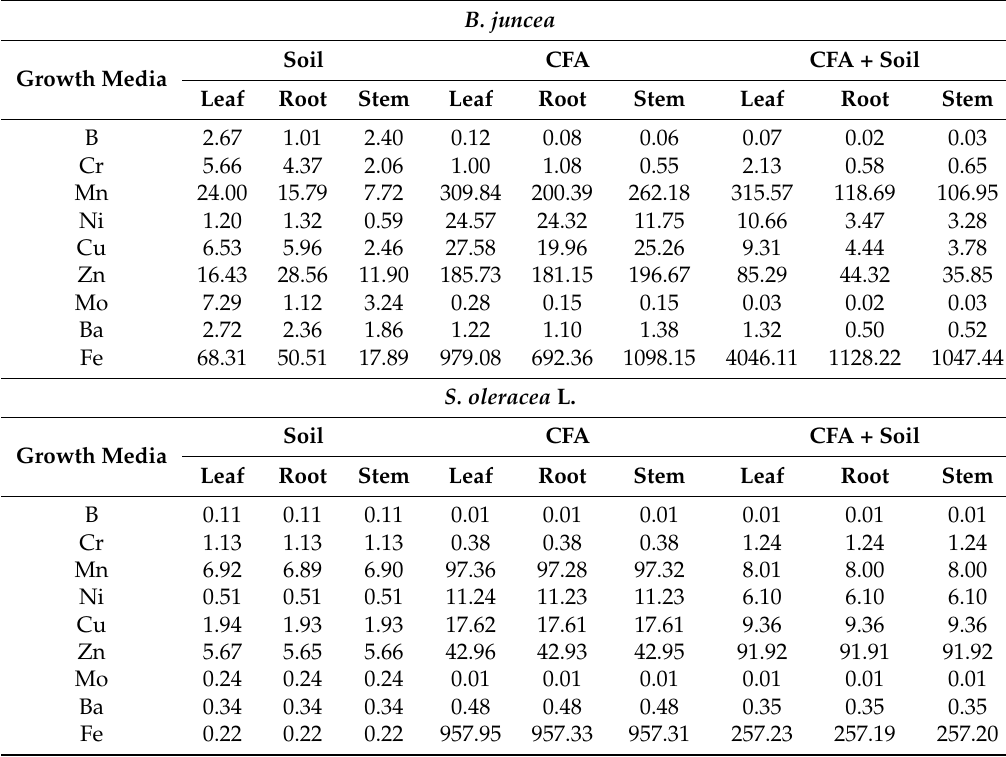
Table 3. Bioconcentration Factor (BCF) for chemical species accumulating in both plant species on Day 115 for all growth